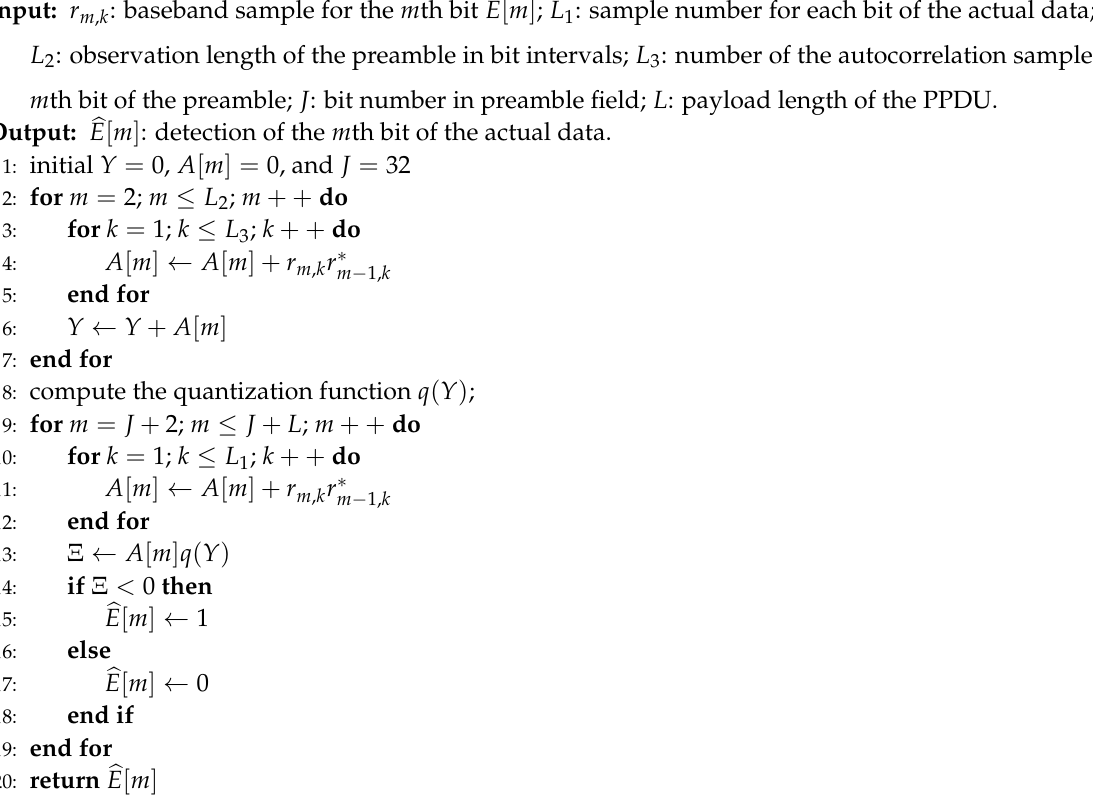
Algorithm 1 Framework of GBSDCD